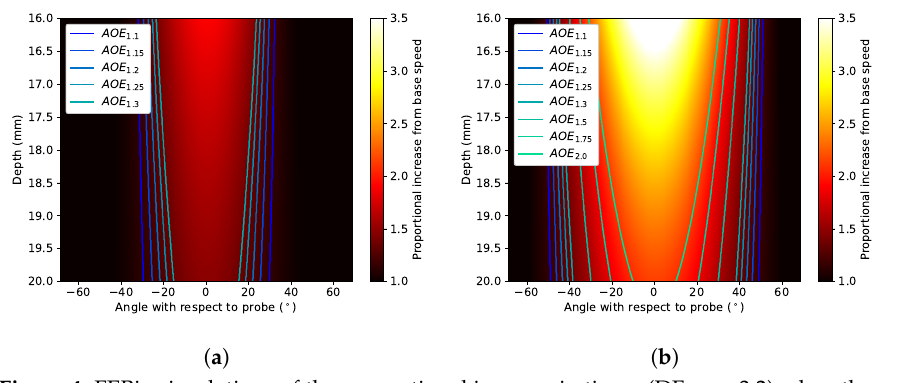
Figure 4. FEBio simulations of the proportional increase in tissue (DF, α = 3.2) when the probe is at ( a ) 8 and ( b ) 14 mm indentations. Borders of proportional increase thresholds are marked by contours on the image. Areas within the borders have a proportional increase from base speed higher than stated thresholds.